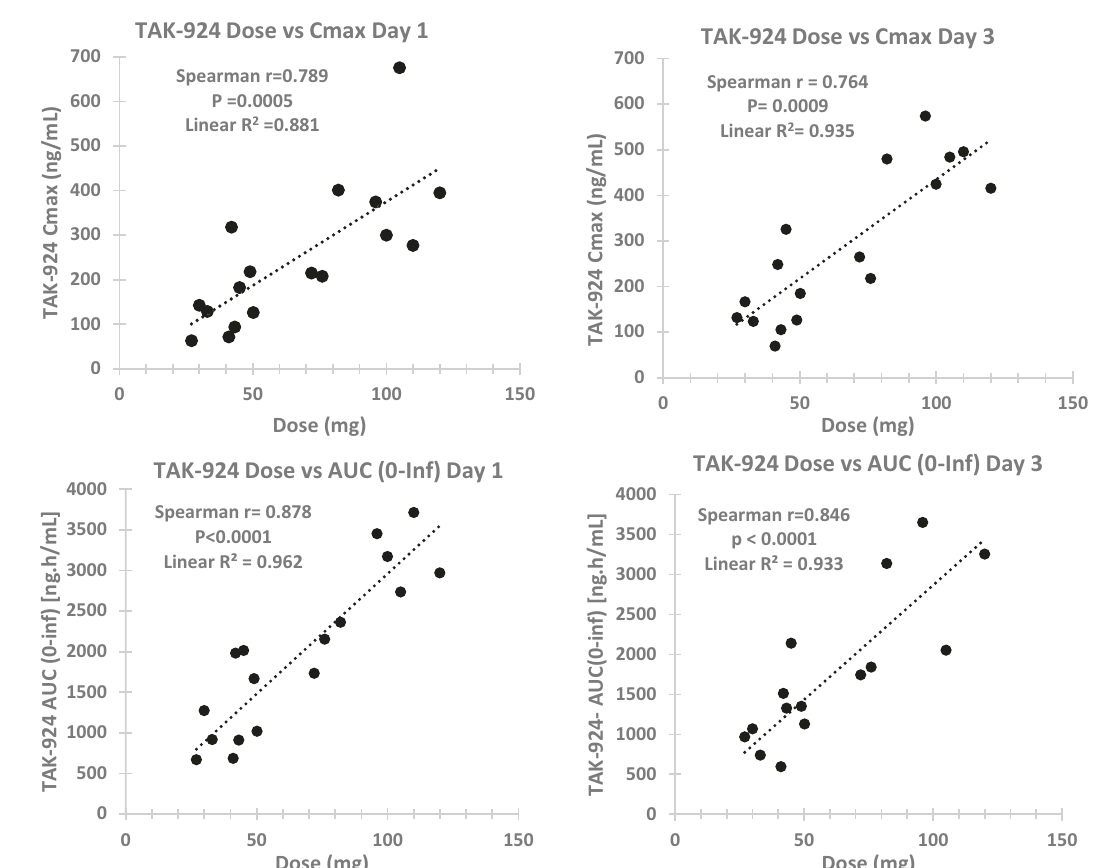
Fig. 2 Pharmacokinetics of pevonedistat. Pevonedistat C max and AUC vs dose on days 1 and